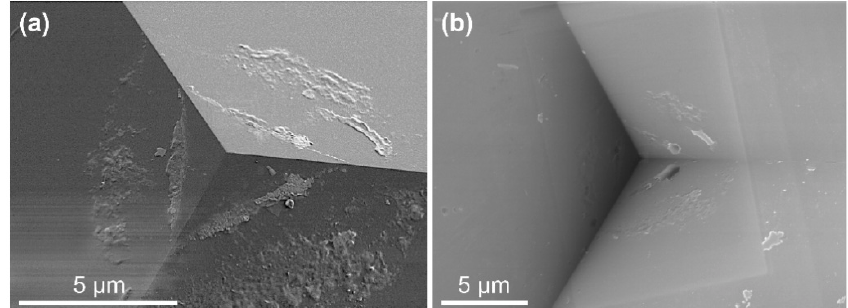
Figure 8. SEM images of a Berkovich tip contaminated with oil paints ( a ) before and ( b ) after manual cleaning with cotton swab soaked in isopropanol.